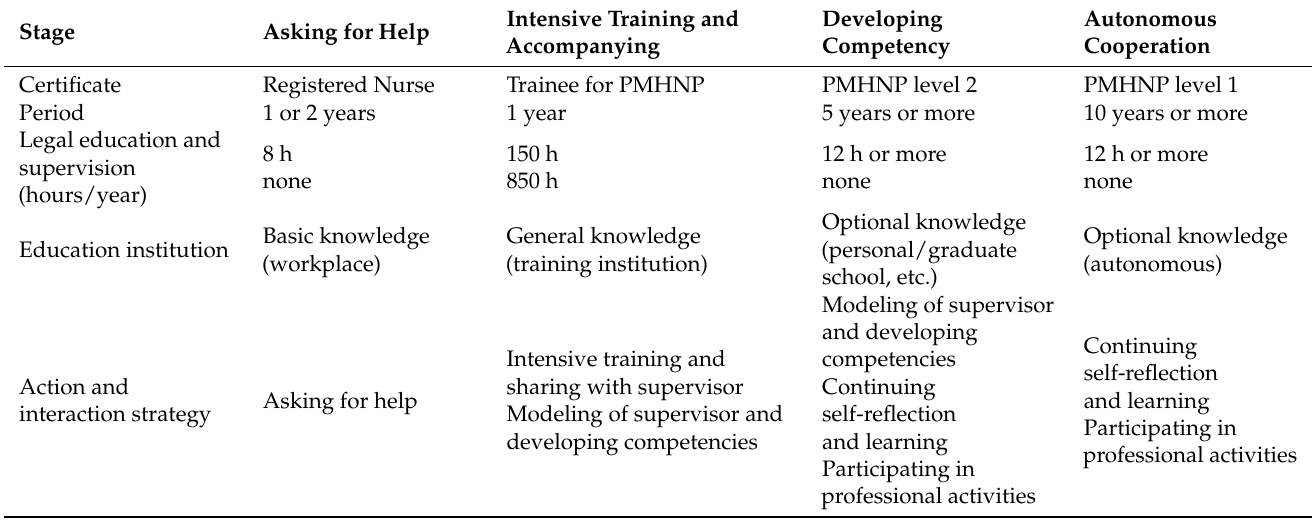
Table 3. Characteristics of the process of “becoming health care experts by supporting each